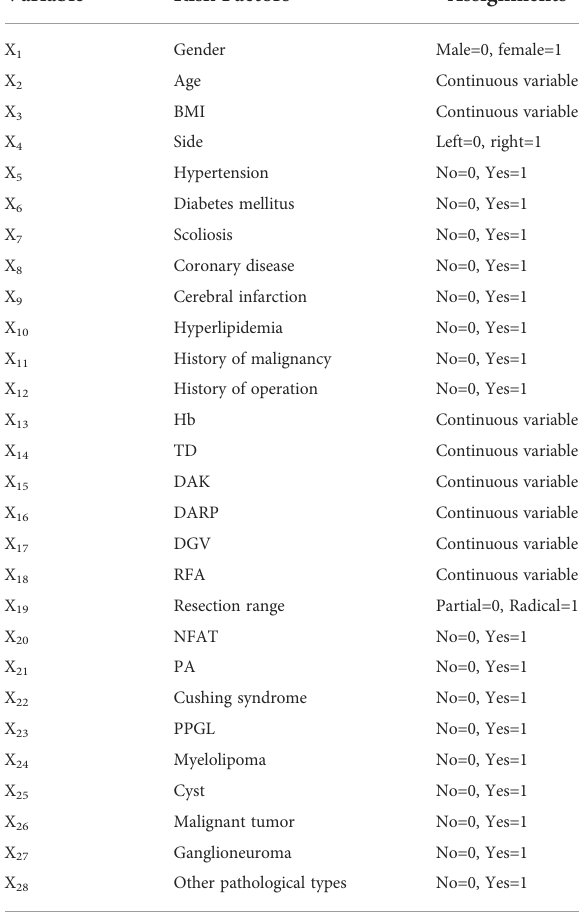
TABLE 3 Variable